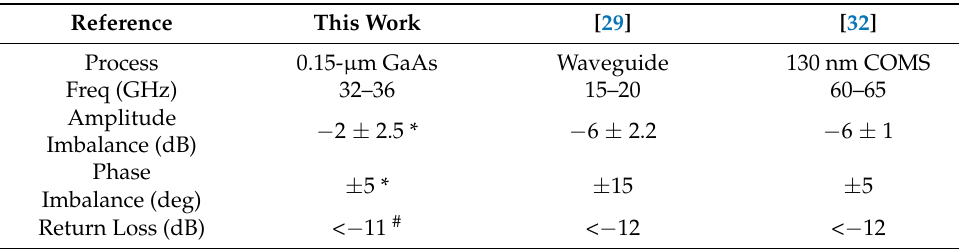
Table 2. Comparison table of the six-port circuit.